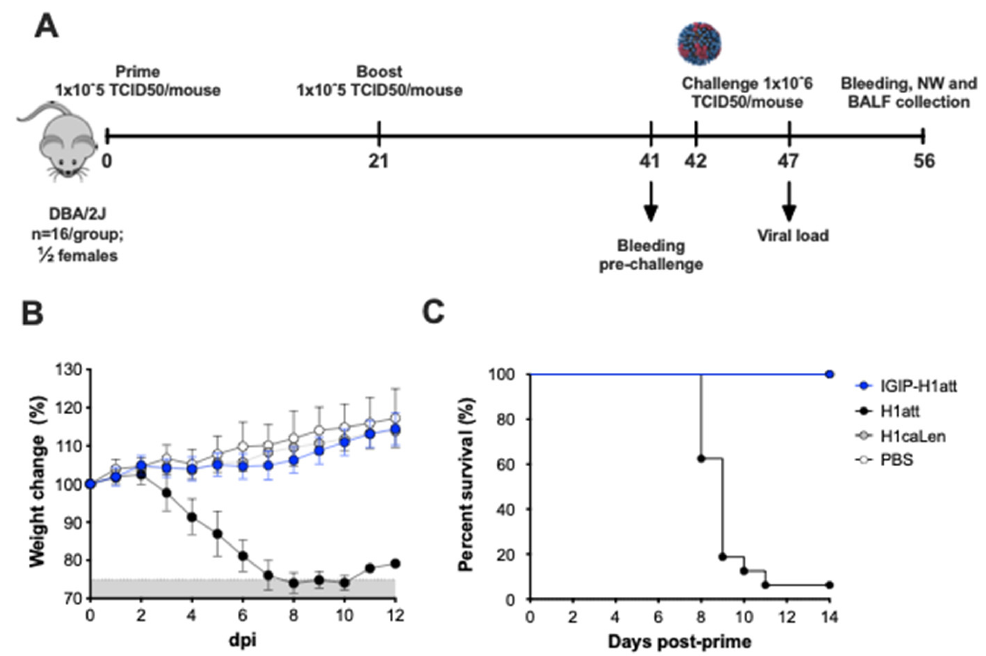
Figure 2. In vivo safety evaluation of IGIP-H1att, H1att, and H1caLen in DBA/2 J mice. ( A ) Schematic representation of the evaluation of the different viruses in DBA/2 J model. Mice ( n = 16) were mock inoculated (PBS; white circles) or inoculated with 1 × 10 5 TCID50/mouse of IGIP-H1att (blue circles), H1att (black circles) or H1caLen (grey circles). ( B ) Weight changes (grey area below the 75% mark the point where mice have reached a humane endpoint) and ( C ) Survival were monitored for 14 days after virus inoculation.